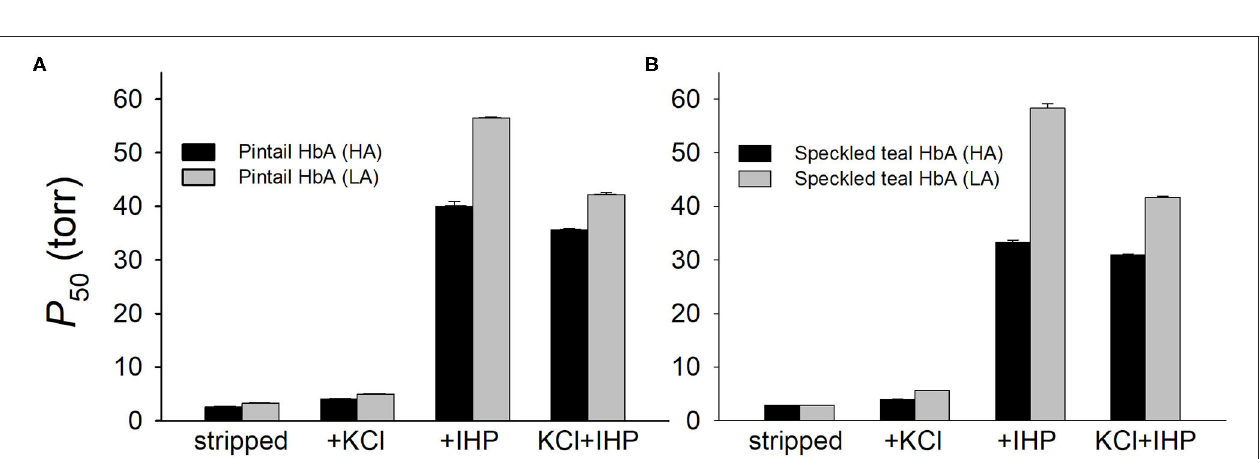
FIGURE 5 | Oxygenation properties of the major HbA isoforms from high- and low-altitude populations of (A) yellow-billed pintail, Anas georgica , and (B) and speckled teal, Anas flavirostris . In both species, alternative HbA variants that predominate in high- and low-altitude populations differ at two sites, β A 116 and β A 133. HA, high-altitude; LA, low-altitude. P 50 -values (means ± SEM) of purified HbA were measured at pH 7.4 and 37 ◦ C in the absence (stripped) and presence of allosteric effectors: chloride ions (added as KCl) and inositol hexaphosphate (IHP) ([Cl − ], 0.1M; [HEPES], 0.1M; IHP/Hb tetramer ratio, 2.0; [Heme], 0.300mM). Based on data in Natarajan et al.